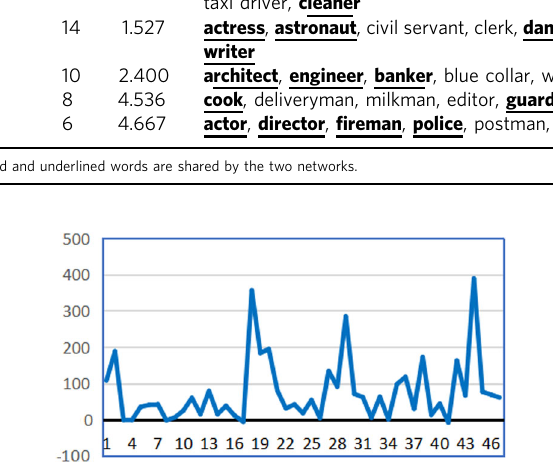
Fig. 6 Degree increase of common words in two networks. The horizontal axis is the common words of the two networks and the vertical axis their increased degree.